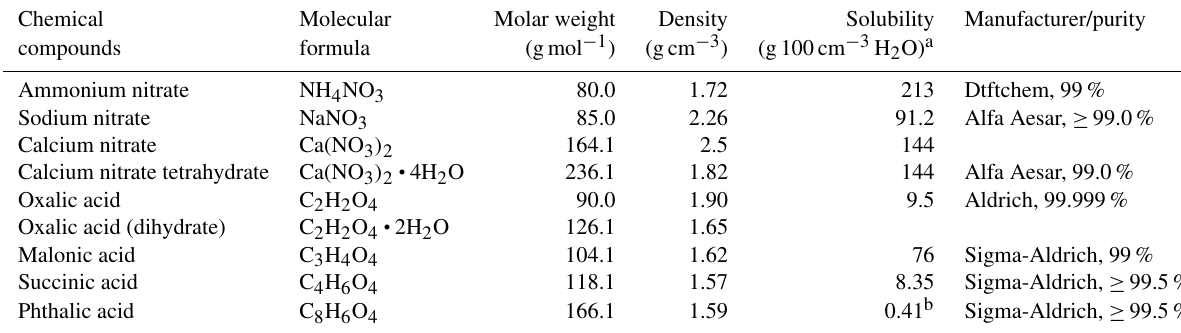
Table 1. Chemical properties of substances investigated in this study. Chemical Molecular Molar weight Density Solubility Manufacturer/purity compounds formula Ammonium nitrate Sodium nitrate NaNO